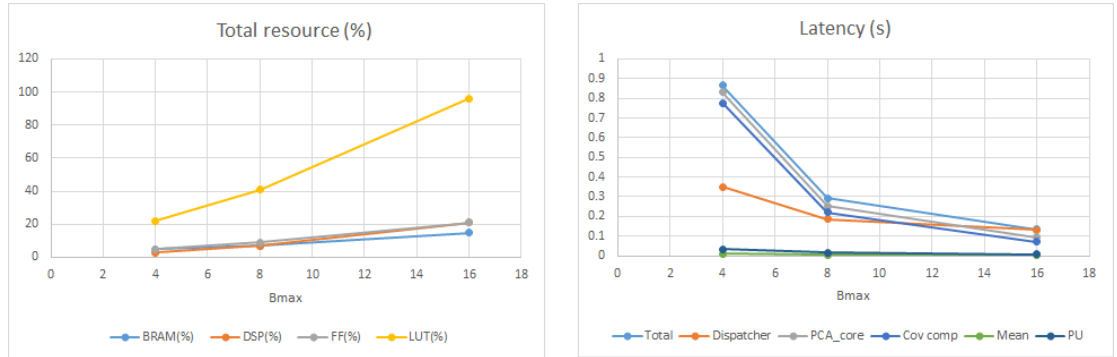
Figure 9. Impact of block size ( B max ) on the resource usage and latency for the Virtex7, bands = 48, pixels = 300 × 300, floating-point